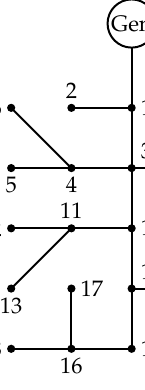
Figure 1. The 21-node